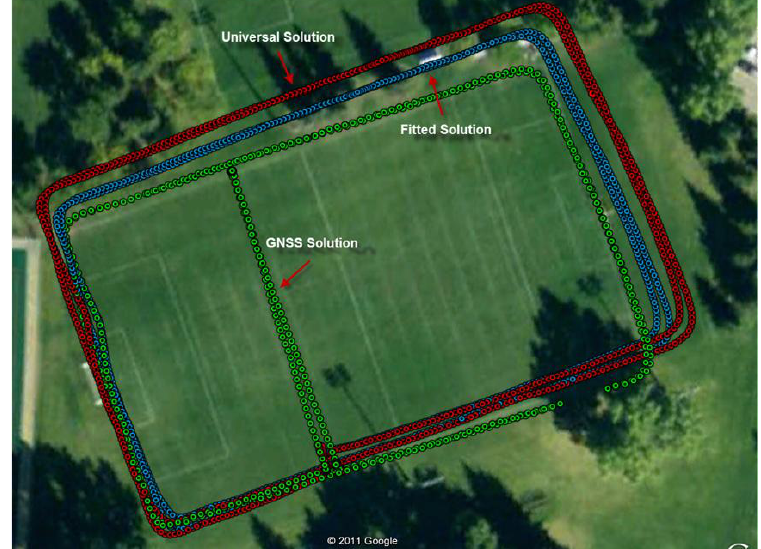
Figure 10. Reference path in green and estimated trajectories: modeled step length with the universal parameters in red and with the calibrated parameters in blue for the test subject with the worst performance